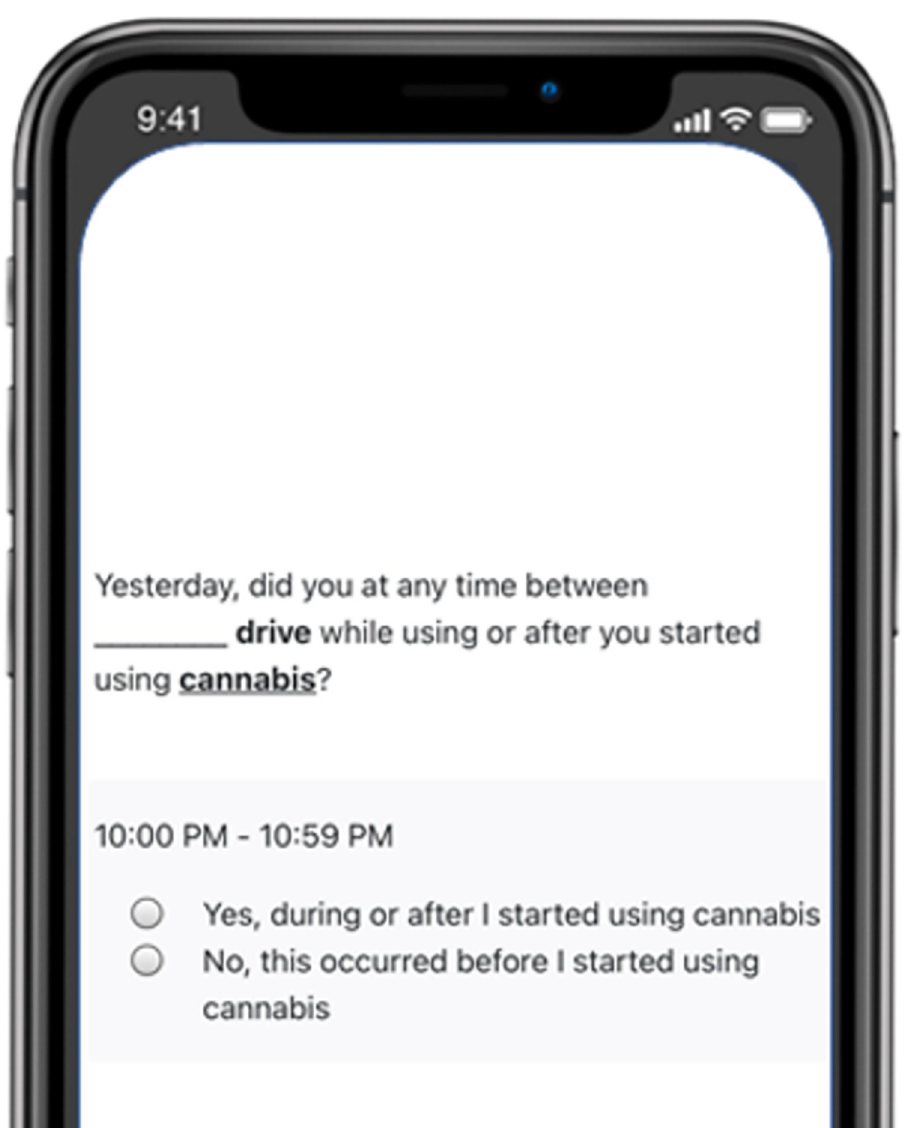
Fig 2. Example of question assessing overlapping transportation and substance use. Note: For every 1-hour period a participant chooses for both a transportation and alcohol and/or cannabis use question, they are provided with this follow-up question to determine when transportation occurred in relation to the substance